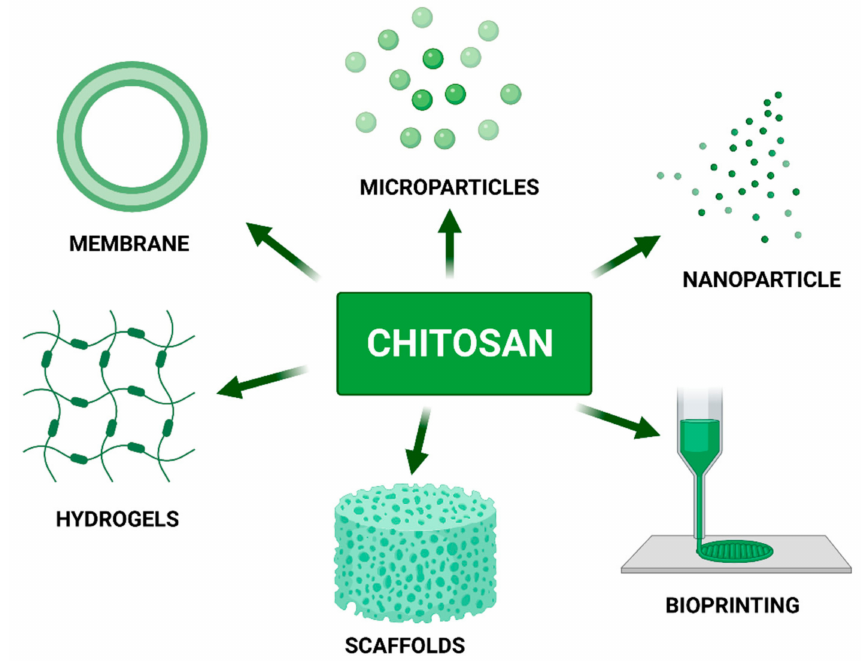
Figure 4. Chitosan application as a material dedicated to